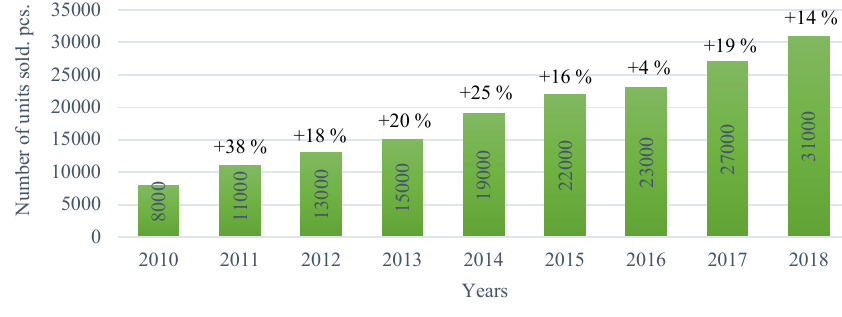
Fig. 9. The development of heat pump sales in Poland.